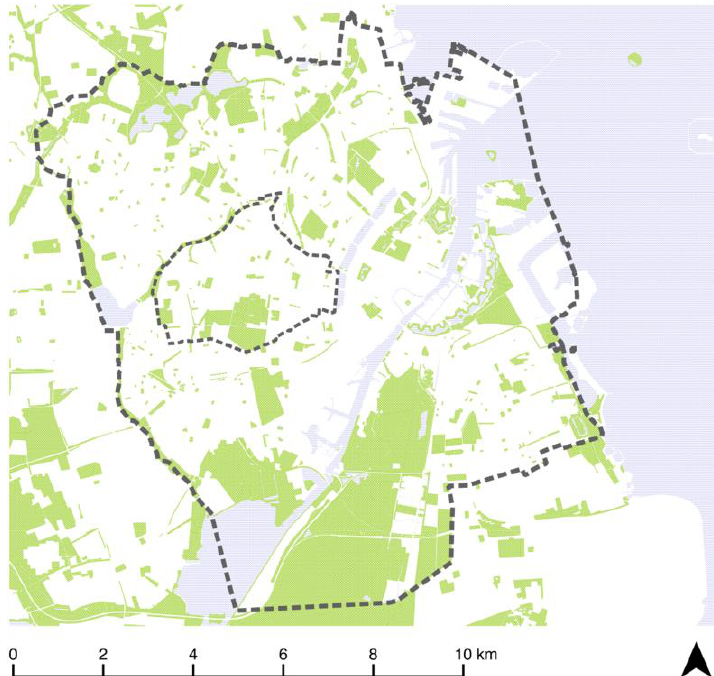
Figure 1. The study area consists of the central part of the Copenhagen region, which is defined as the administrative delineation of the municipalities of Copenhagen (outer dashed line) and Frederiksberg (inner dashed line). Officially designated blue and green spaces form the central building blocks of the city’s Urban Green Infrastructure. Source: Municipality of